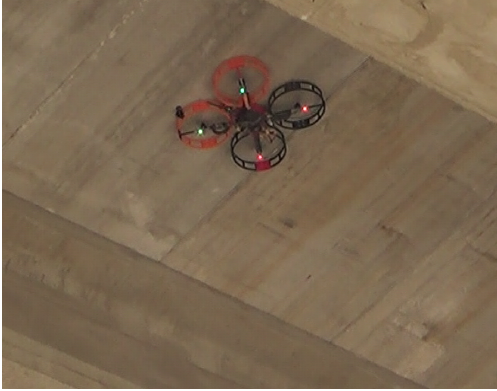
Figure 1. Prototype of multirotor system operating in contact with the